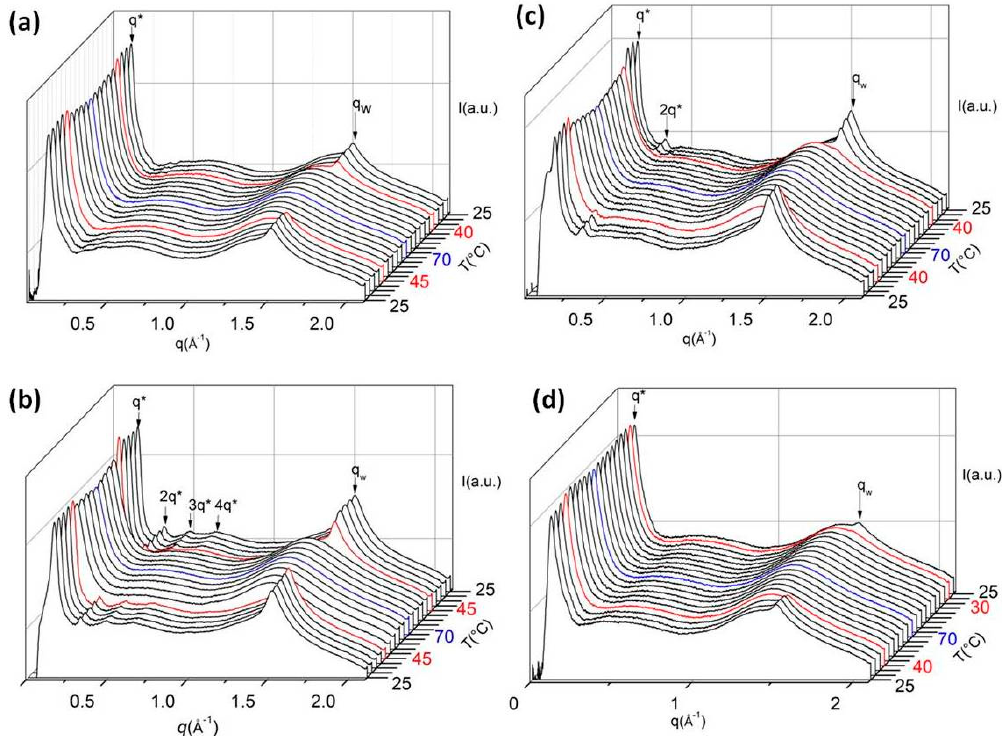
Figure. 4. Combined SAXS and WAXS traces during heating and cooling cycles (5 K step from 25 °C to 70 °C and back to 25 °C) of ( a ) PXA- g -S15; ( b ) PXA- g -S36; ( c ) PDSA- g -S68; and ( d ) SPSA- g -S10. For polymers with relatively high degrees of grafting, a more ordered nanophase separation is observed, for instance, PXA -g- S36 (the volume fraction of hydrophobic side chain is 0.58). Combined SAXS and WAXS heating and cooling scans of PXA -g- S 36 are shown in Figure 4b. At low temperature, one prominent peak in the small angle region ( q *) and several higher order peaks are visible, indicating a lamellar structure caused by nanophase separation of the polymer backbone and the side chains ( d = 38.1 Å) followed by crystallization of side chain [12]. In the wide angle region, only one single peak appears ( q w ). The lattice parameter a = 4.78 Å is nearly identical with that of PXA- g -S15. At the melting temperature of 52 °C, the peak in the small angle region becomes broader and the higher order peaks disappear. This behavior indicates that the lamellar structure is significantly stabilized by the side chain crystallization. After cooling below the crystallization temperature of 45 °C, the higher order peaks appear again.